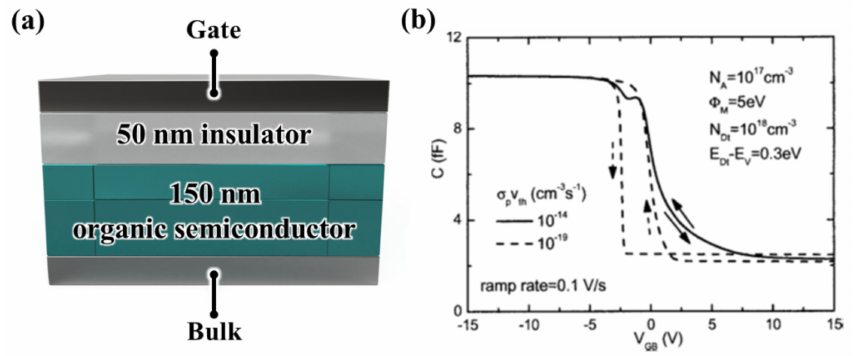
Figure 11. ( a ) Simulated MOS structure and ( b ) simulated CV characteristics for acceptor doping and donor-like trap states near the valence band edge. Reproduced with permission [75]. Copyright © 2005, AIP